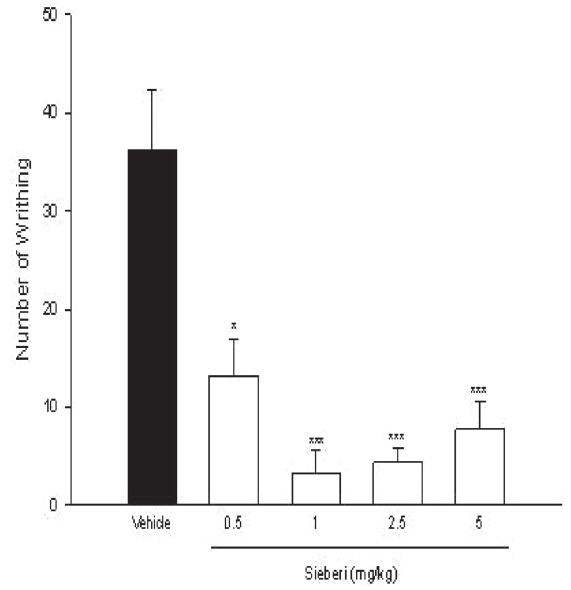
FIGURE 1 - Effect of A. sieberi essential oil on acetic acid- induced writhes in mice. Each value represents the mean ± S.E.M. of eight mice. * P < 0.05, ** P <0.01 and *** P <0.001 compared to the control group using one-way ANOVA followed by Dunnett’s multiple comparison